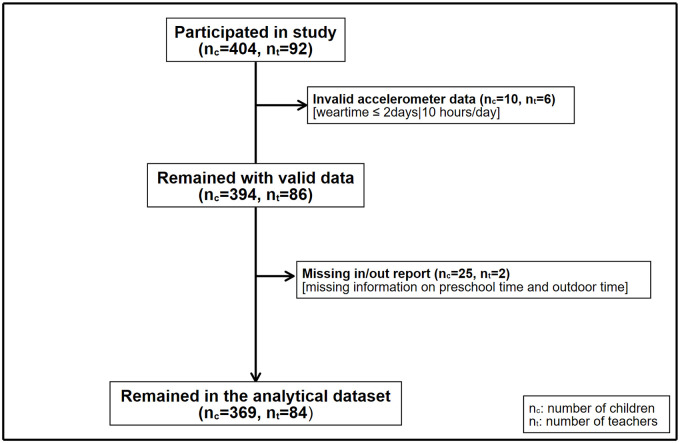
Flowchart of participants.